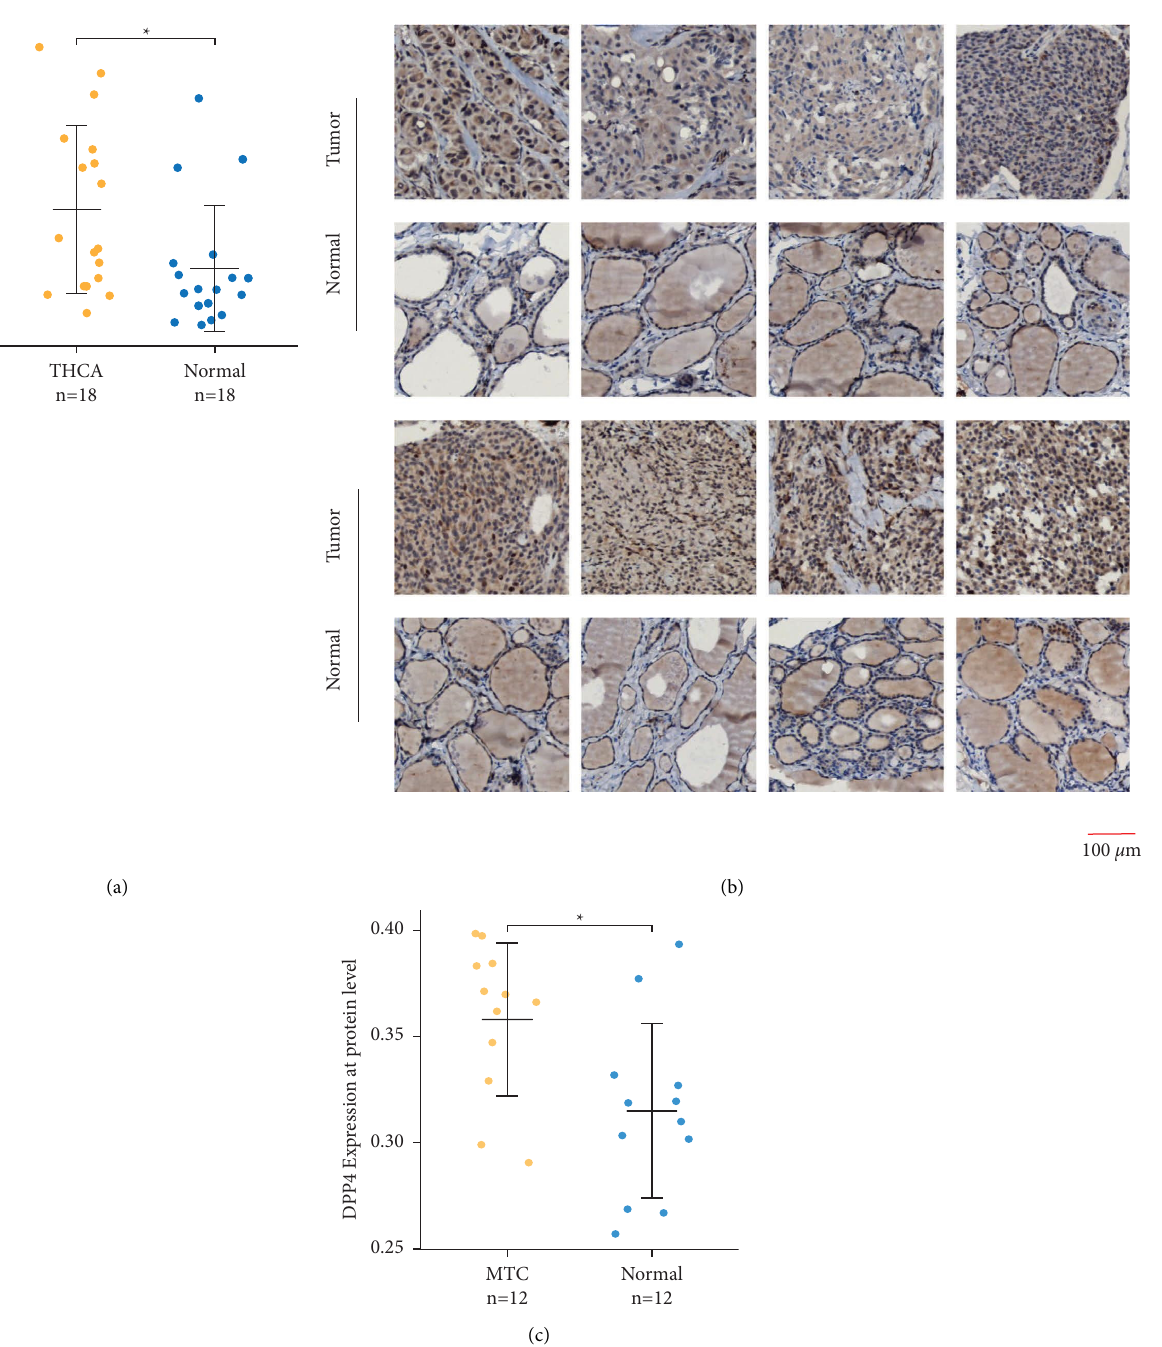
Figure 4: Results of RT-qPCR and IHC. (a) Result of RT-qPCR shows that expression of DPP4 in fresh THCA tissues is higher than that in MANTat the mRNA level ( ∗ p < 0 . 05). (b) Te IHC of 8 pairs of MTC and paracancerous tissues shows that the target protein DPP4 is mainly distributed in the cytoplasm of cancer cells and is stained brown by DAB, while the thyroid follicular epithelium is slightly stained. (c) Quantitative analysis shows that the staining degree in MTC is higher than that in paracancerous tissues ( ∗ p < 0 .